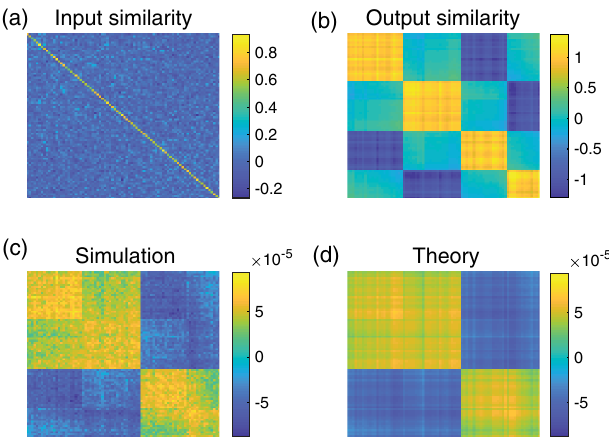
FIG. 8. Hidden representations with multiple outputs. Results